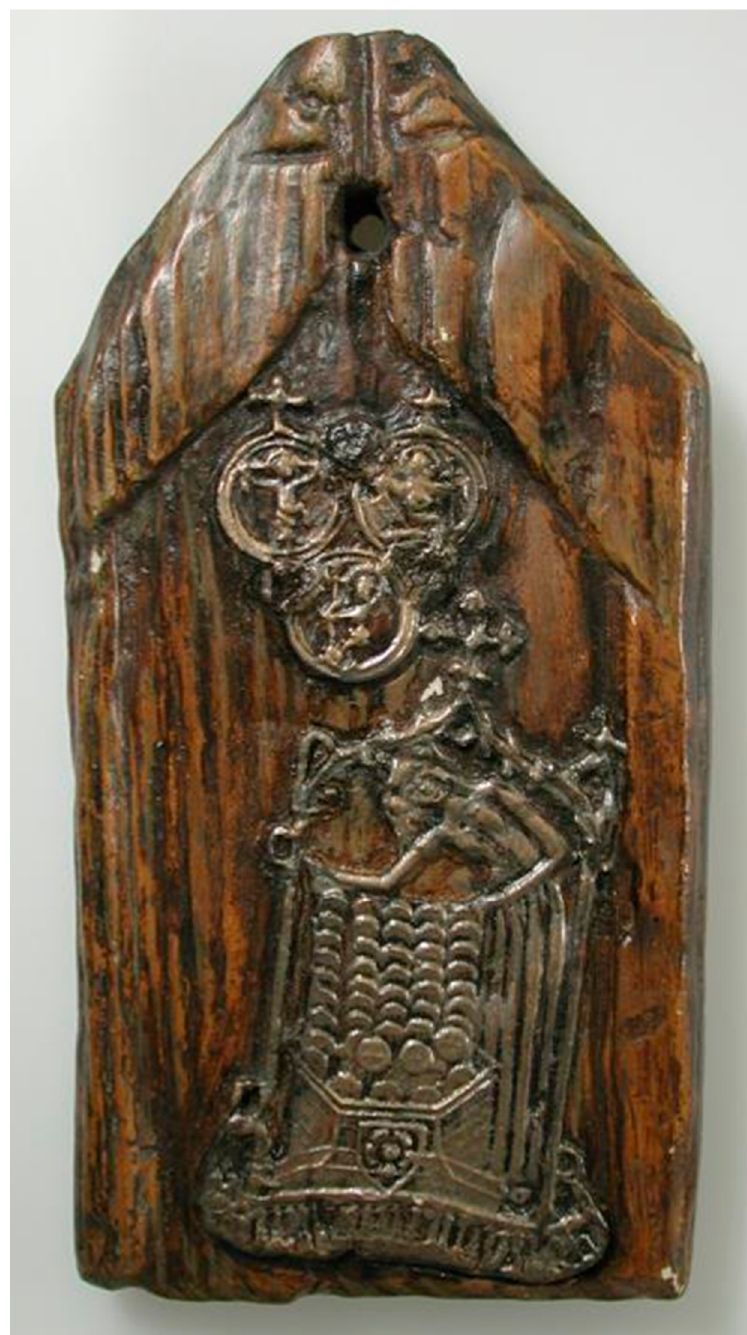
Figure 1. Carved board with pilgrim badges. Amsterdam, Historisch Museum, c. 1500. Badges are from Wilsnack and Blomberg, Amsterdam. Photo: Amsterdam, Historisch Museum.